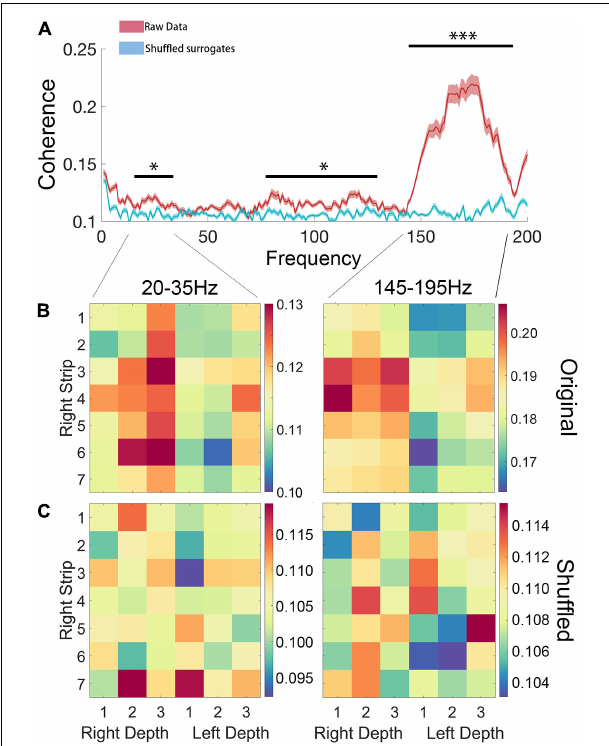
FIGURE 6 | (A) Coherence of ipsilateral ECoG and LFP. Compared with shuffled surrogates, significantly higher coherence ( P < 0.05, FDR correction) was found in high beta (20–35 Hz) and high gamma (145–195 Hz) bands. (B,C) Statistical comparison between original data and shuffled surrogates in high beta (20–35 Hz) and high gamma (145–195 Hz) bands, in which the rows and columns of matrix entries represent ECoG and LFP channels (“Right Strip 1–7” represent each channel of the ECoG, “Right Depth 1–3” represent each channel of the LFP of right STN and “Left Depth 1–3” represent each channel of the LFP of left STN) and the color scheme indicates the significant level of coherence (*P < 0.05; ***P < 0.001).